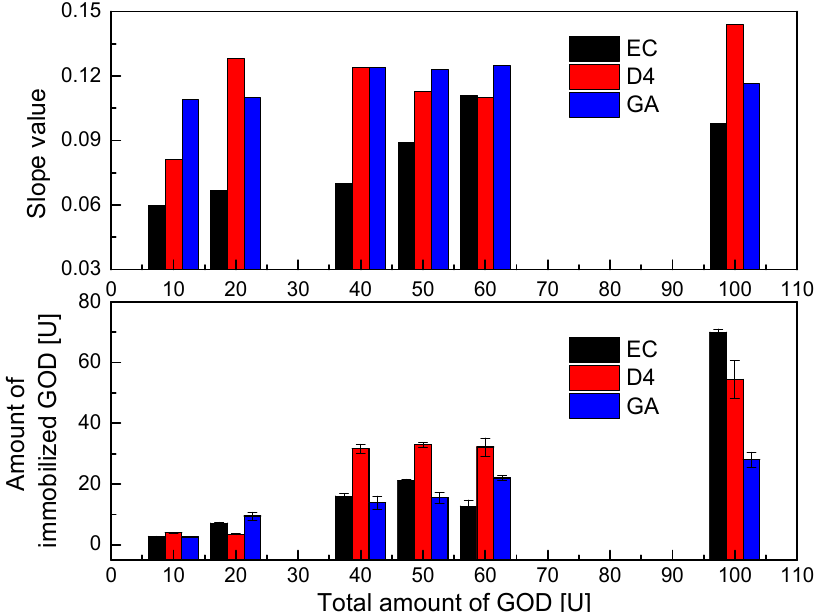
Figure 4. Immobilization efficiencies of different amounts of GOD on different supporting layers (EC, D4, GA) and slope values of calibration curves of GOD = PS@C6^PtP membranes in glucose concentration range of 0–2 mM.